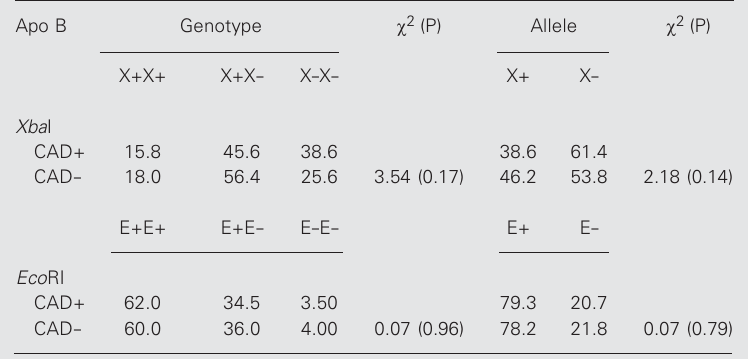
Table 2. Genotype and allele frequencies of Xba I and Eco RI (apo B gene) in the CAD+ (N = 114) and CAD- (N = 78) groups.